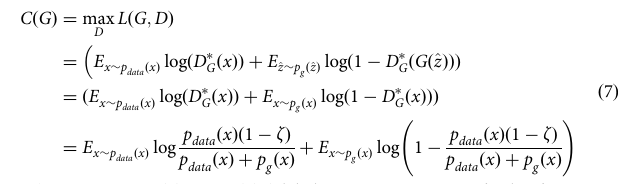
Table 5 A brief summary of the datasets used in the